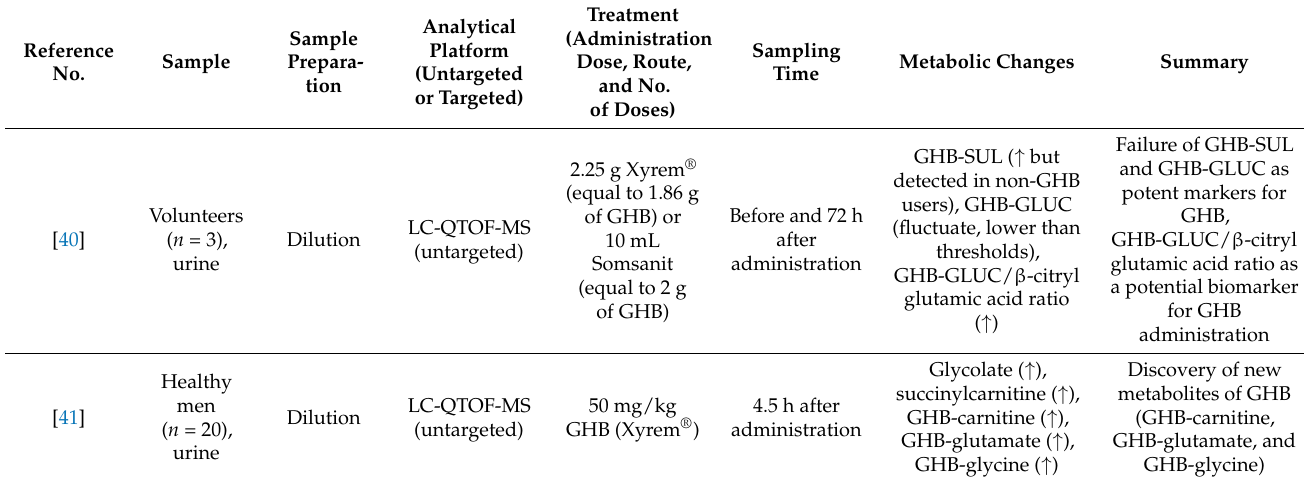
Table 3. Summary of analysis of GHB-conjugates and other metabolites in human biological samples from GHB users.